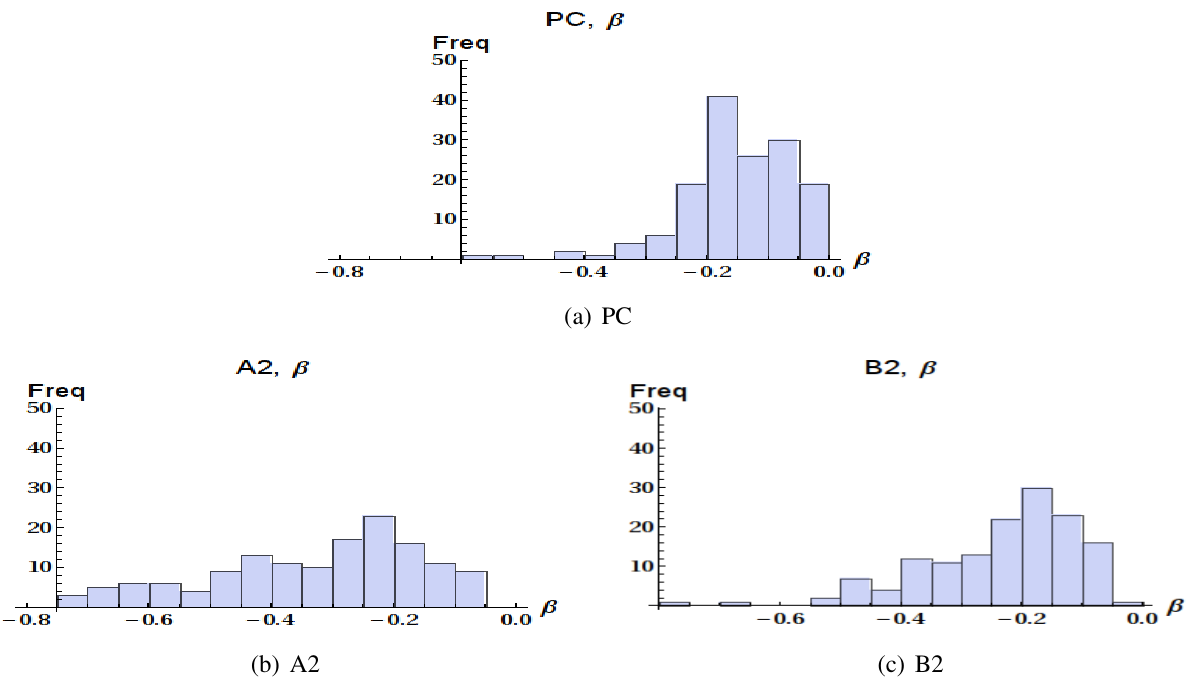
Figure 8. Distributions of the values of the β parameter of Equation (1).